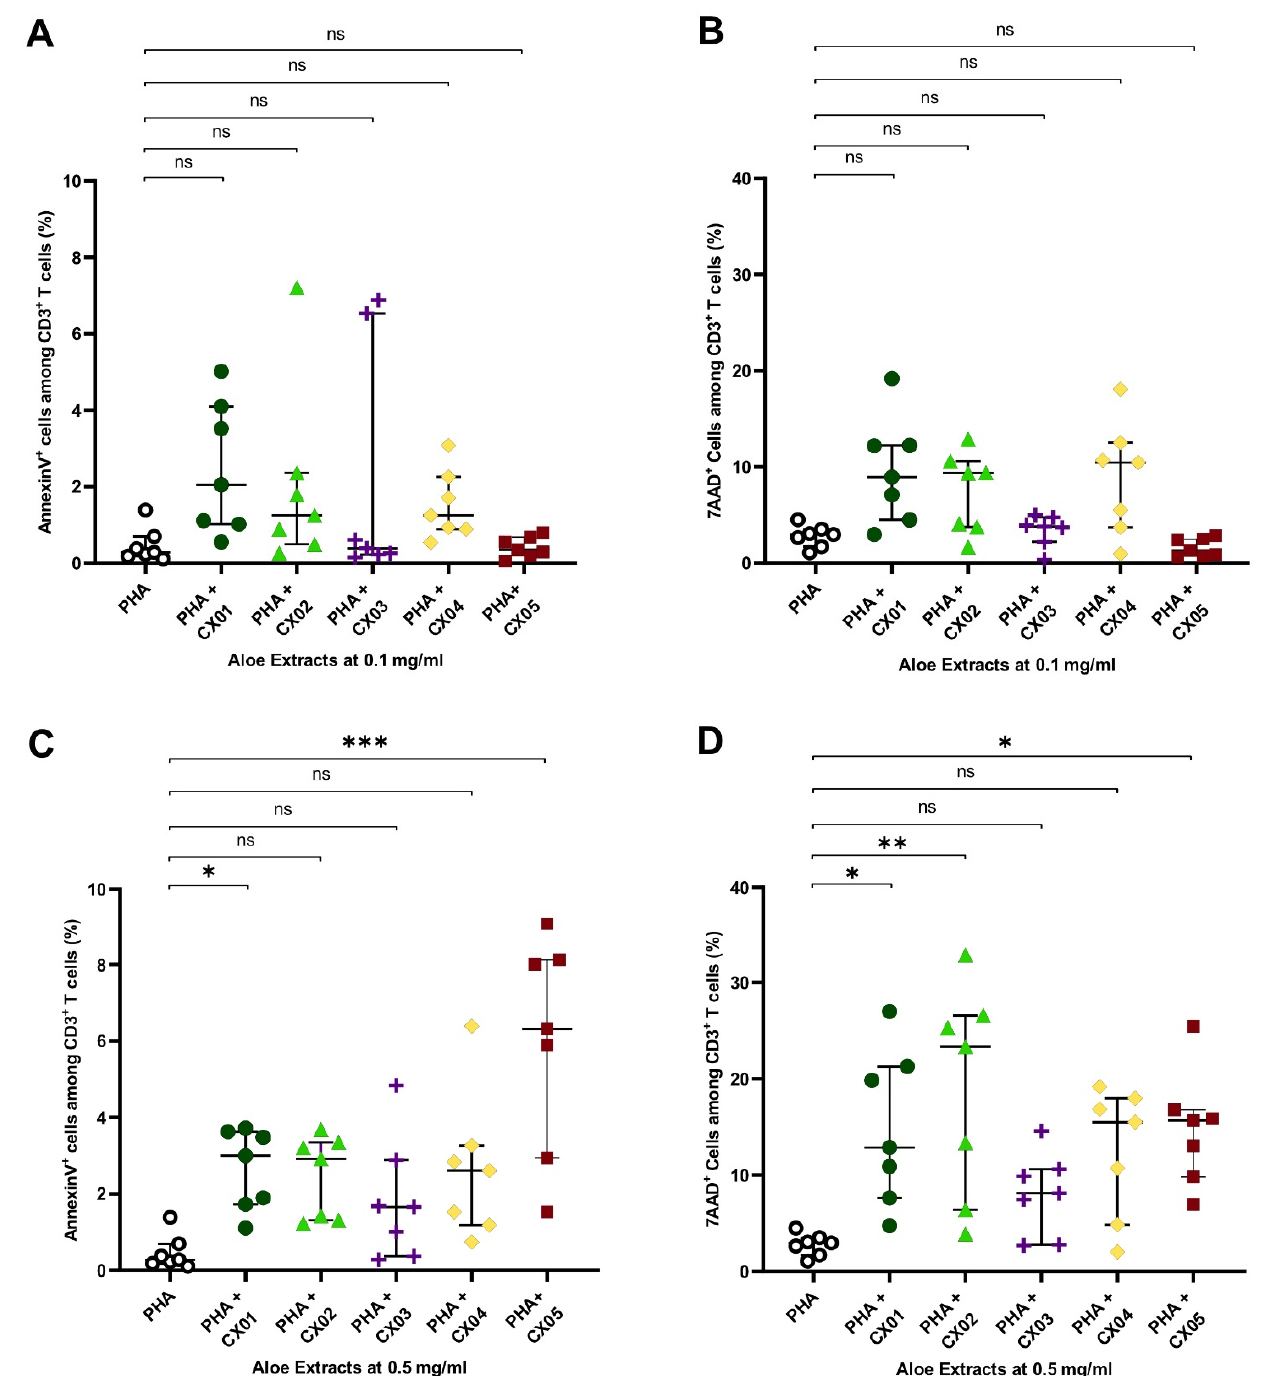
Figure 2. Effect of Aloe extracts on apoptosis and cell death in polyclonally stimulated T cells. Total PBMCs from seven donors were stimulated with PHA in the presence or absence of increasing concentrations of Aloe extracts (0.1 and 0.5 mg/mL). ( A , C ) The frequency of Annexin V + cells among CD3 + T cells, indicative of apoptotic cells. ( B , D ) The frequency of 7AAD + cells among CD3 + T cells, indicative of cell death. Asterisks represent significant p values: * <0.05; ** <0.01; *** <0.001. ns: not significant.